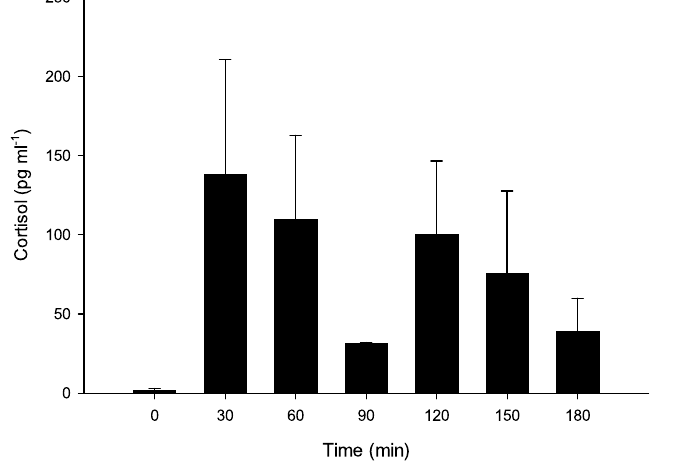
Figure 3. Hormonal response of Cucumaria frondosa to contactless exposure to the chemical signature of a predator over 180 min (3 h). Cortisol concentration in pg ml −1 (mean ± SE; n = 2–6) was measured in the hydrovascular fluid of the Polian